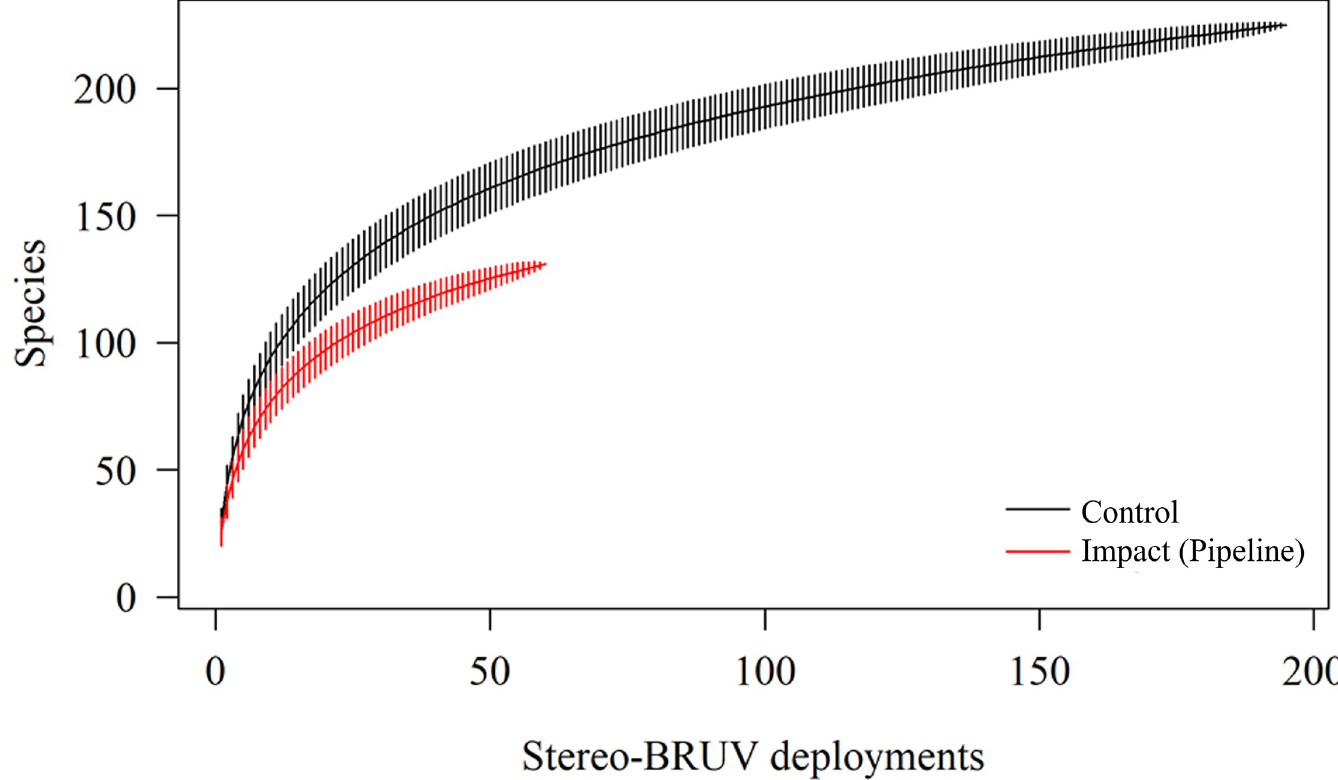
Fig 2. Species accumulation (rarefaction) curves for each